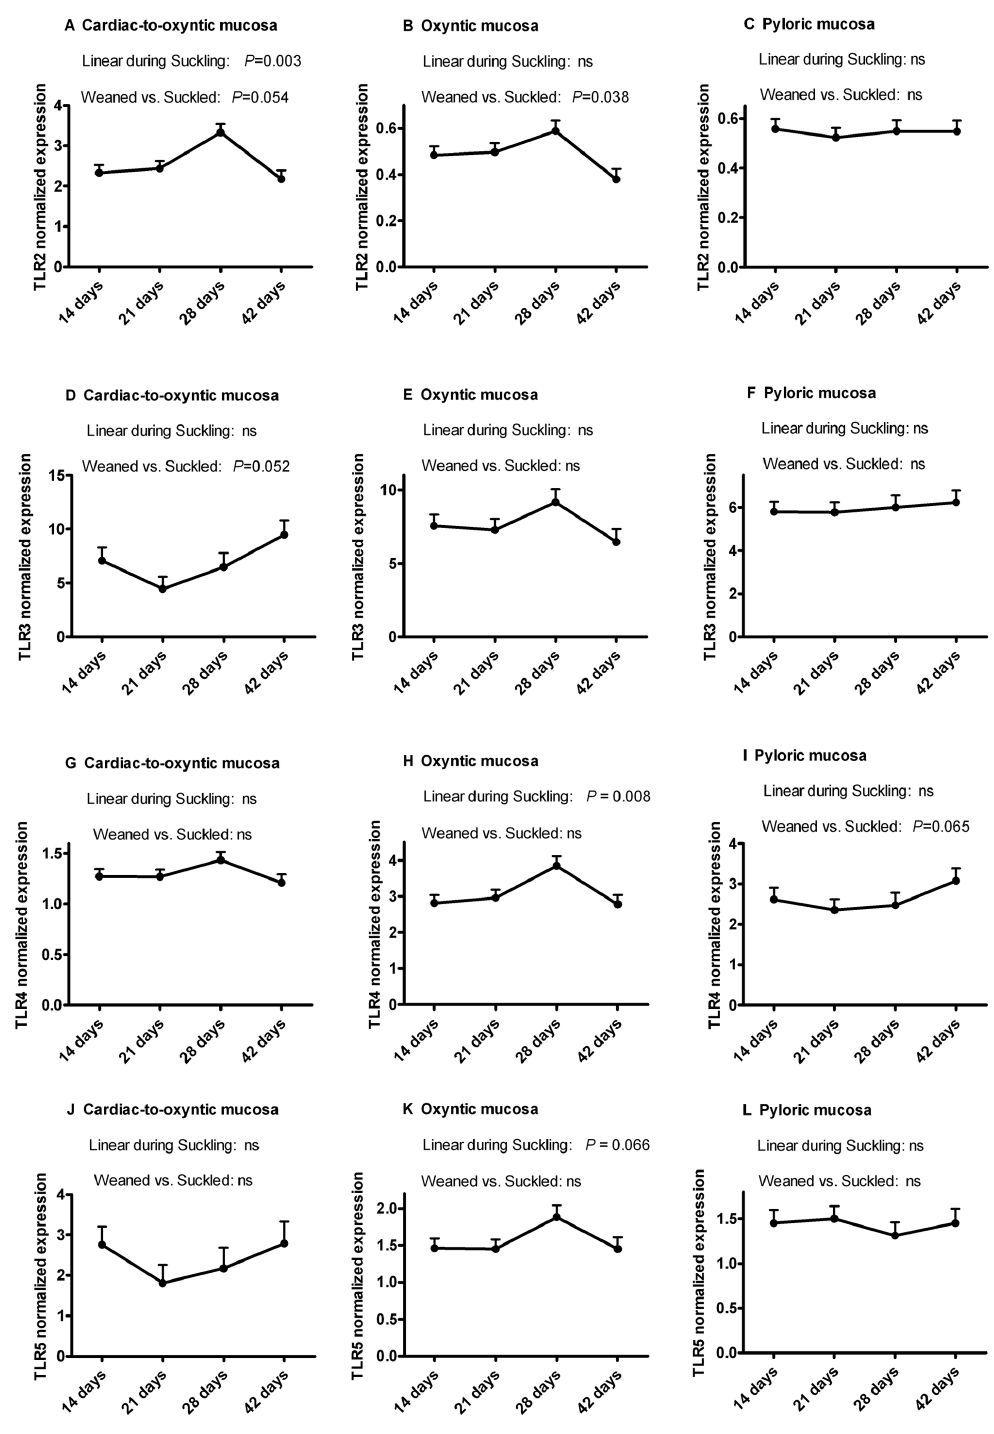
Figure 2. Toll-like Receptor (TLR) mRNA expression in pig gastric mucosa. Expression of TLR2 (A-C), TLR3 (D-F), TLR4 (G- I) and TLR5 (J-L) mRNA expression was determined in three sites of the gastric mucosa of piglets during the suckling period (14, 21 and 28 days of age) and after weaning (42 days of age). TLRs expression was modulated during development in the oxyntic mucosa, where TLR2 decreased after weaning (P=0.038) and TLR4 linearly increased during suckling (P=0.008), and in the cardiac-to-oxyntic mucosa, where TLR2 linearly increased during suckling (P=0.003). For the three gastric sites, no significant quadratic effect during suckling was detected ( P >0.05). doi: 10.1371/journal.pone.0081473.g002 PLOS ONE |